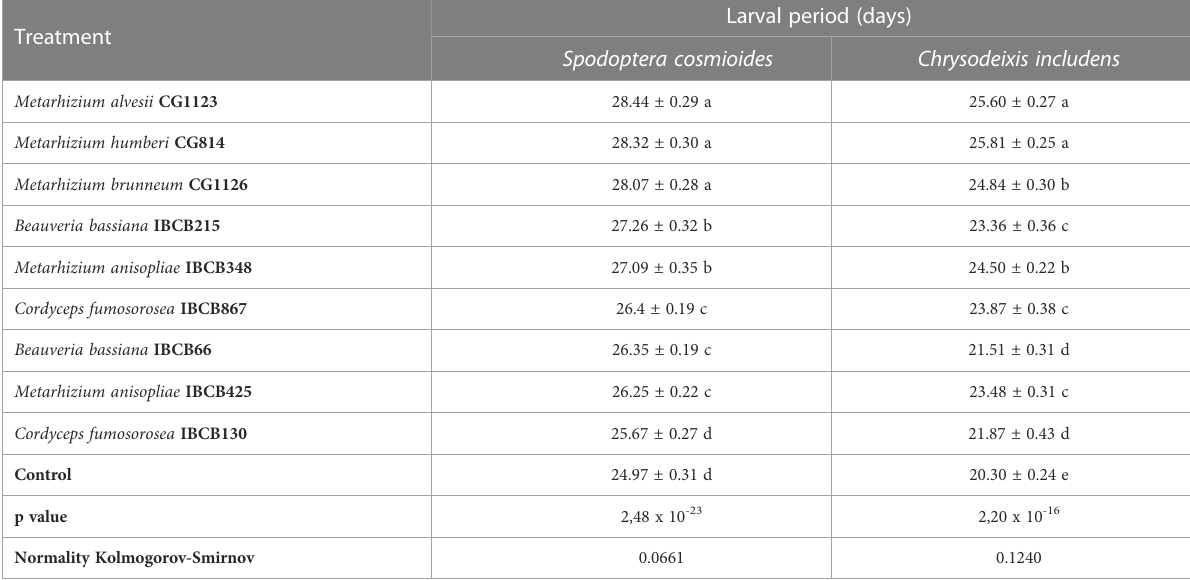
TABLE 4 S. cosmioides and C. includens larval period after feeding on peanut plants inoculated with entomopathogenic fungi and uninoculated control.